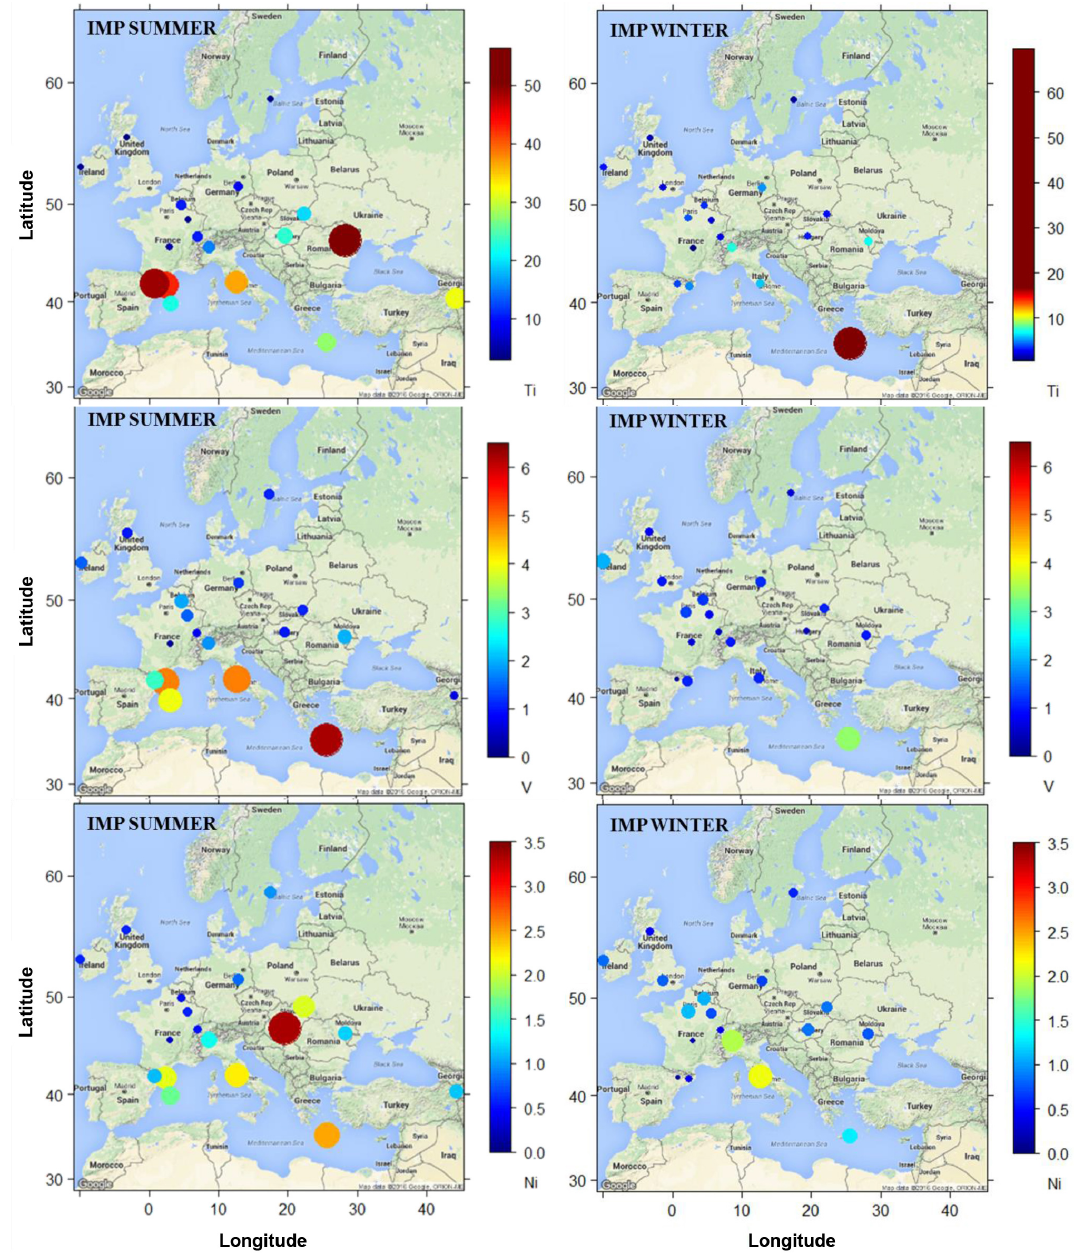
Figure 13. Spatial distributions of the mean concentrations (in ngm − 3 ) of Ti, V, and Ni, determined at each site during the summer and the winter EMEP IMPs. The diameter of the circles is proportional to the